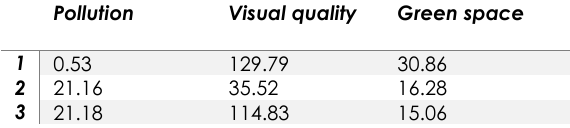
Table 3. Environmental Data Matrix. Pollution Visual